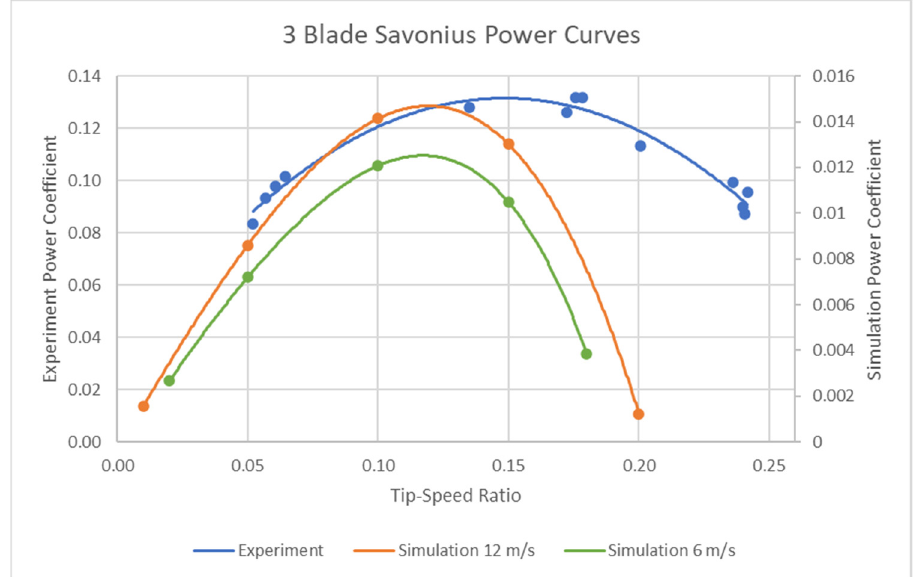
Figure 24. Three-blade Savonius simulation and experiment